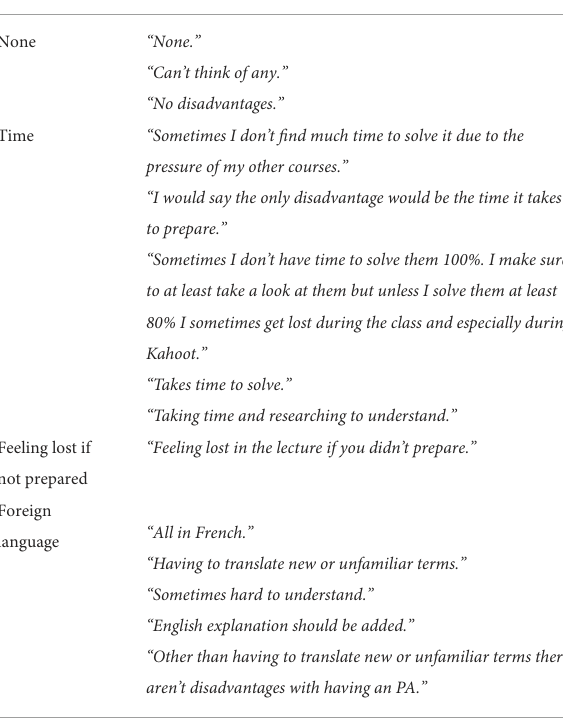
TABLE 6 Student answers to the question: What are the disadvantages of flipped learning (having PA to prepare)?